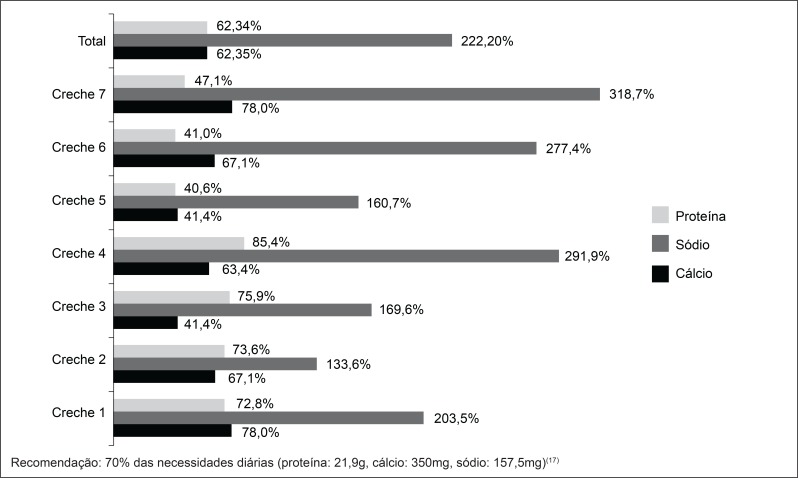
Percentual de recomendação de proteína, cálcio e sódio em creches
públicas. São Paulo, SP, 2010